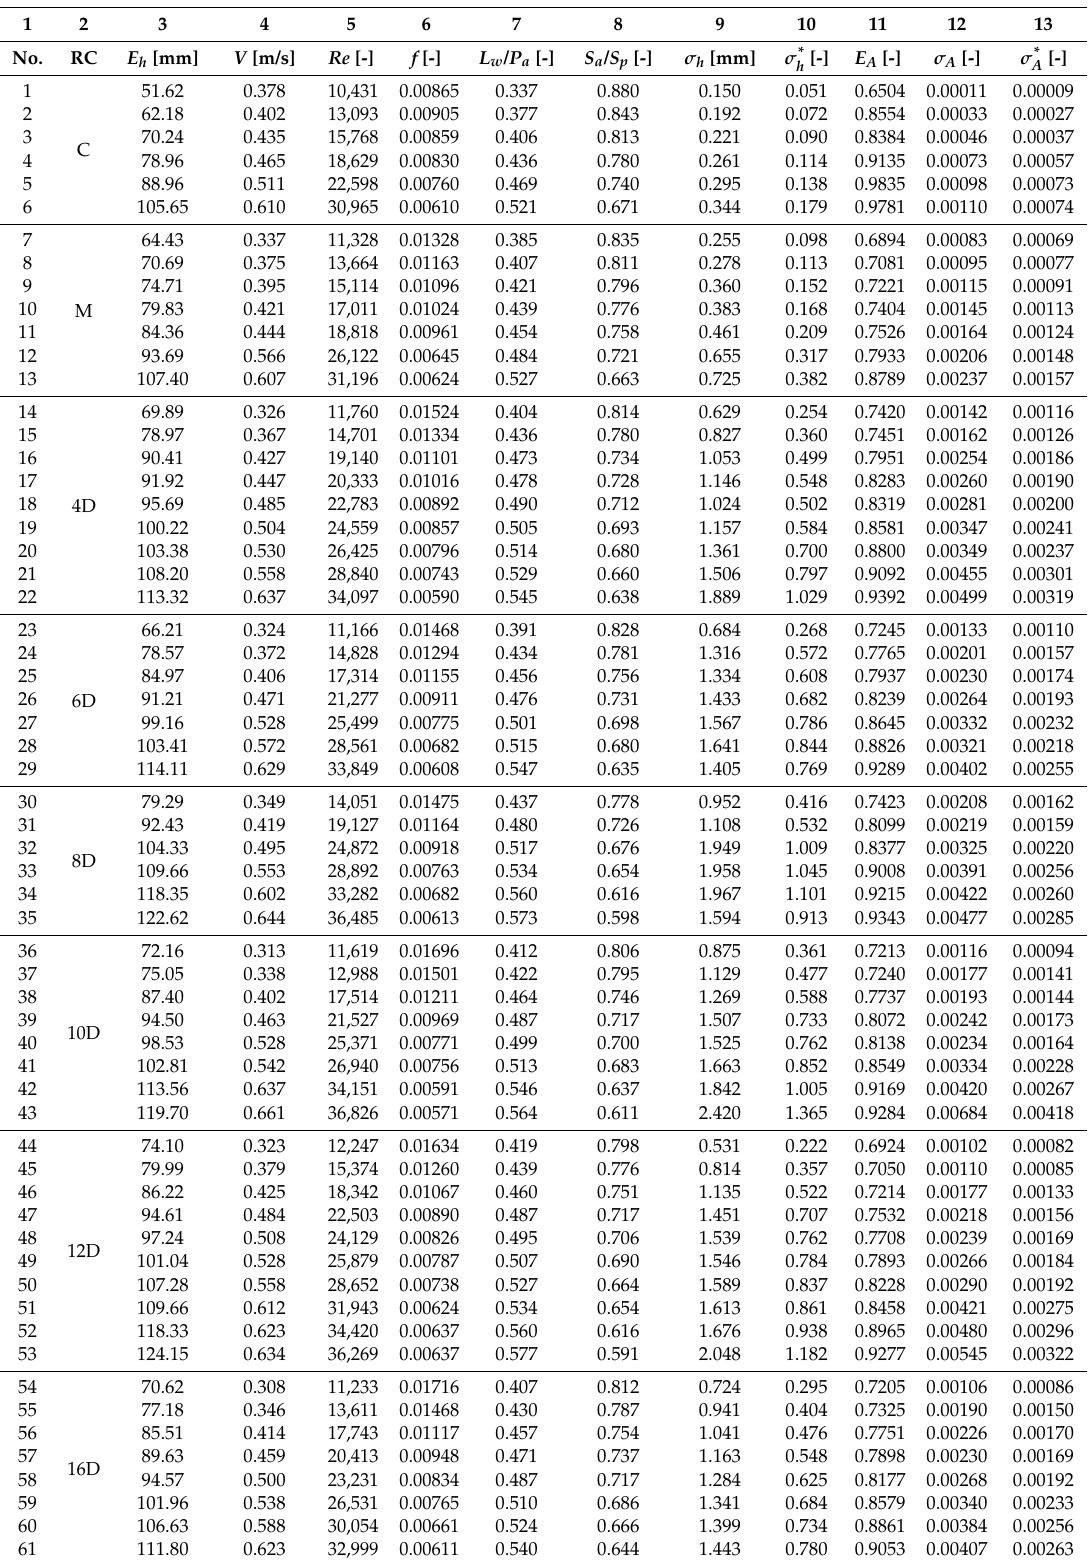
Table 2. The summary of all experimental regimes with measured hydraulic